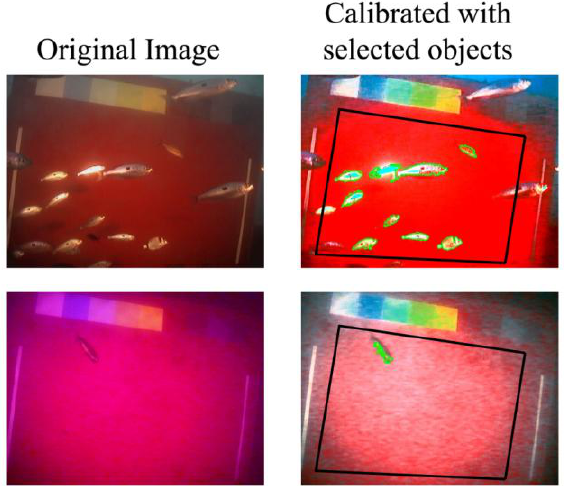
Figure 5. Examples automated processing of time-lapse images acquired by the OBSEA coastal cabled observatory at both day and night-time. Two examples of original images (on the left; above day, below night) and their chromatically calibrated outputs (on the right) were reported as an example of fish identification performance. The black polygon represents the ROI and selected object selected by the Roberts edge algorithm within it are evidenced with a green